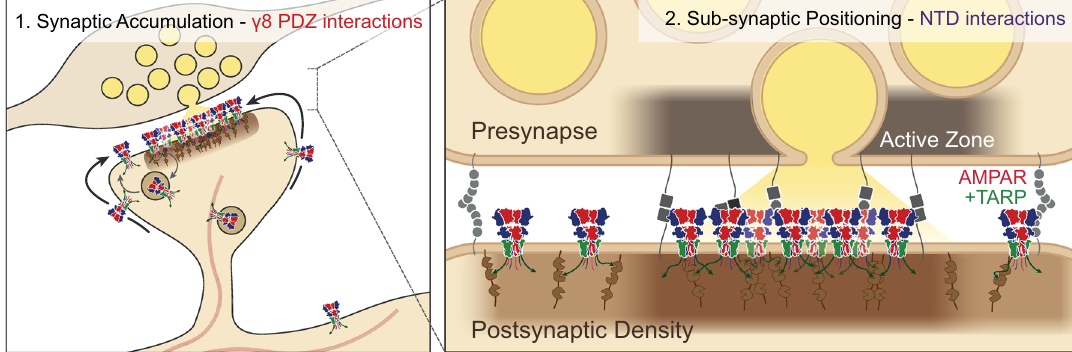
Fig. 7 Proposed model outlining the differential role of TARP and NTD interactions on AMPAR CA1 synaptic anchoring. TARP PDZ and NTD interactions are critical for synaptic transmission. CTD interactions may in fl uence receptor traf fi cking and recycling. TARP γ 8 PDZ interactions drive accumulation of receptors at synaptic sites (left). NTD interactions may control subsynaptic receptor localisation for contribution to functional transmission